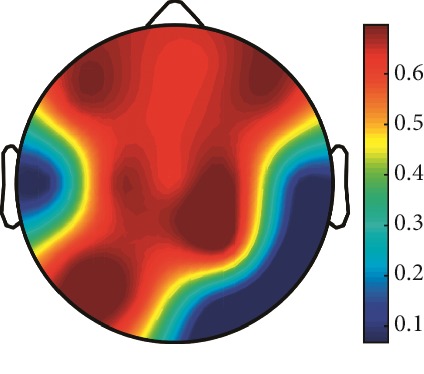
Seizure frequency.